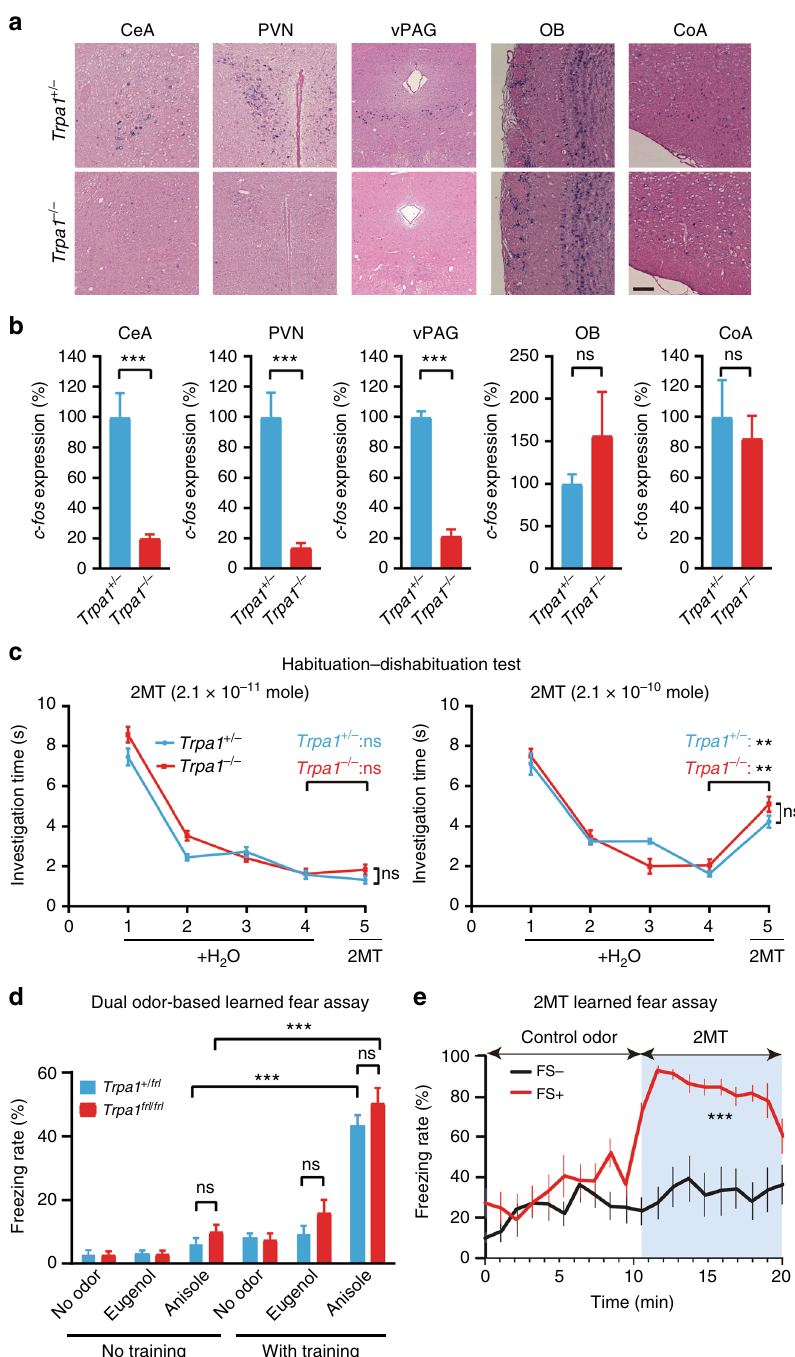
Fig. 4 Trpa1 − / − mice can smell and learn to fear 2MT. a Representative images showing c-fos mRNA in situ hybridization (ISH) of the central nucleus of amygdala (CeA), paraventricular nucleus (PVN) of hypothalamus, ventral periaqueductal gray (vPAG), olfactory bulb (OB), and cortical amygdala (CoA) regions of the brains of 2MT-exposed Trpa1 + / − and Trpa1 − / − mice (bar: 100 µ m). b Quantitative analysis of c-fos -positive neurons in the CeA, PVN, vPAG, OB, and CoA of Trpa1 + / − and Trpa1 − / − mouse brains ( a ). The relative measure (%) of c-fos signals of Trpa1 − / − samples is normalized to those of Trpa1 + / − controls. Data are presented as mean ± SEM ( n = 4, Student ’ s t -test, *** P < 0.001; ns not signi fi cant). c Habituation-dishabituation test results of Trpa1 + / − and Trpa1 − / − mice exposed to fi lter papers containing H 2 O (trials 1 – 4) or 2MT (trial 5). 2MT dose was shown above the left and right graphs (left graph: n = 6 for both Trpa1 + / − and Trpa1 − / − mice, Student ’ s t -test; ns not signi fi cant; right graph: n = 5 for Trpa1 + / − mice and n = 4 for Trpa1 − / − mice, ** P < 0.01). d Dual odor-based learned fear assay was performed with Trpa1 + /frl and Trpa1 frl/frl mutant mice by pairing anisole with electric footshock and using eugenol as a negative control. Data are presented as mean ± SEM ( n = 10, Student ’ s t -test, *** P < 0.001; ns not signi fi cant). e Trpa1 − / − mice were untrained ( − FS) or trained ( + FS) to fear 2MT by pairing 2MT exposure with electric footshocks. Eugenol was used as a control odor. Data are presented as mean ± SEM ( n = 6, Student ’ s t -test, *** P < 0.001; ** P < 0.01; * P <